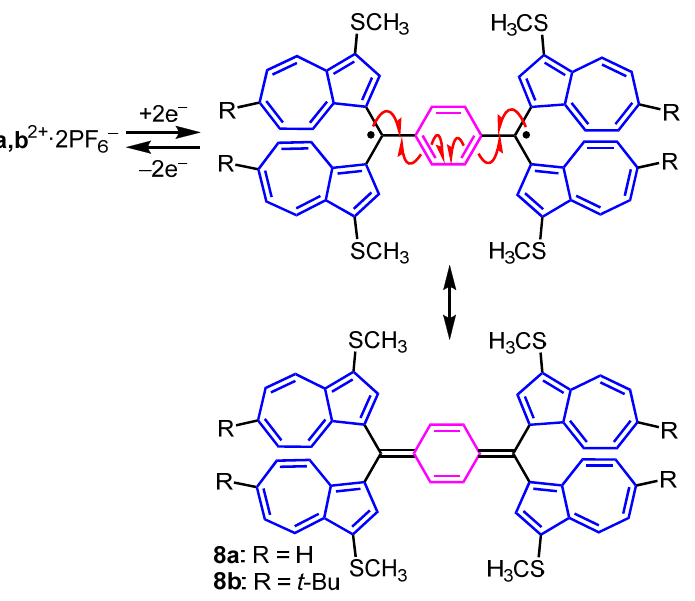
Figure 7. Plausible redox behavior of 4a , b 2+ ·2PF 6 − and generated quinoidal species 8a , b .